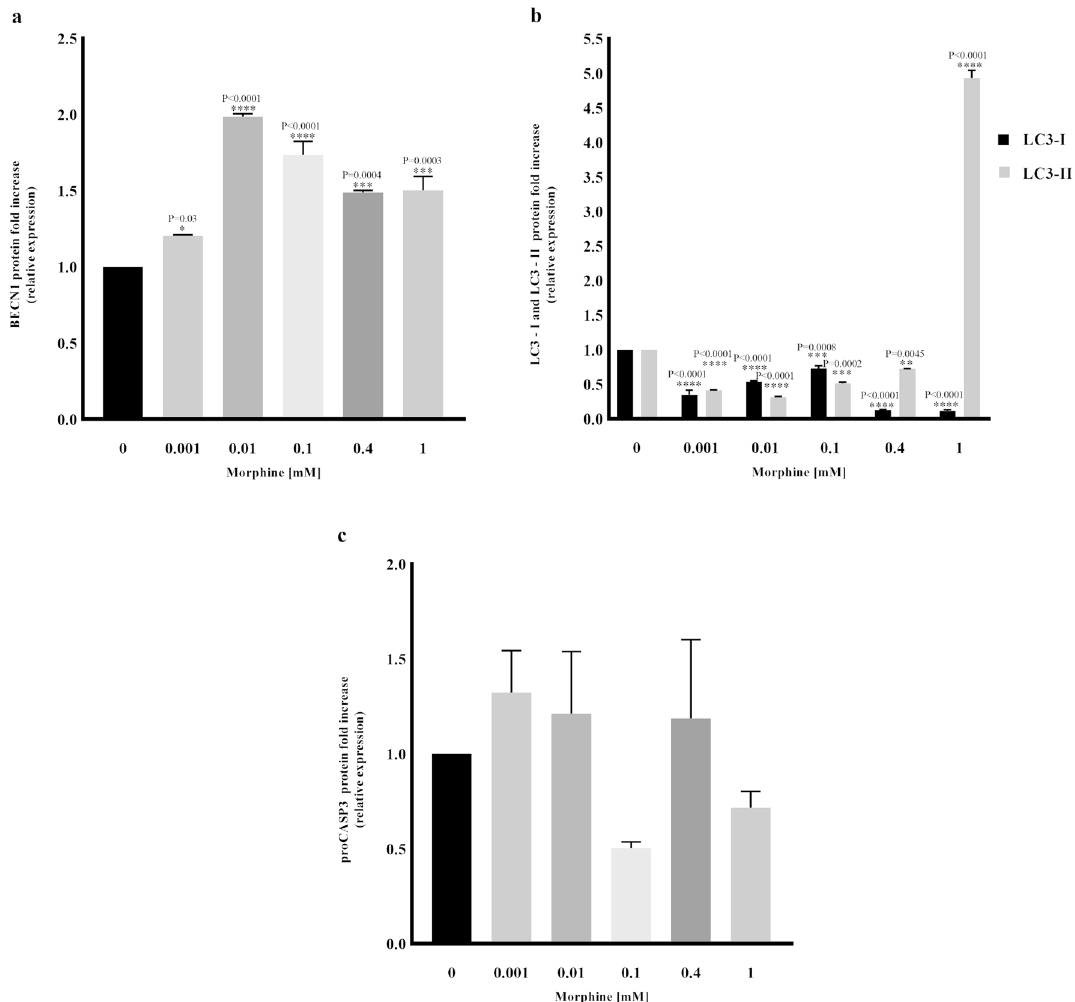
Figure 6. Densitometric analysis of western blot data, carried out after eighteen days of morphine sulphate exposition. The reported values are expressed as mean ± SD of three independent experiments and represented as fold changes compared to non-treated samples (0 mM). Relative amounts of BECN1, LC3 (LC3-I and LC3-II) and proCASP3/CASP3 protein expression were normalized to the intensity of tubulin protein. ( a ) Morphine sulphate induced a BECN1 expression enhancement already at 0.001 mM in a dose–response manner. ( b ) 1 mM morphine exposition caused a five-fold LC3-II fragment upregulation ( b ). Both results suggest that prolonged exposure of morphine may induce an increase of autophagy. ( c ) The presence of unvaried levels of proCASP3 suggests low or absent levels of